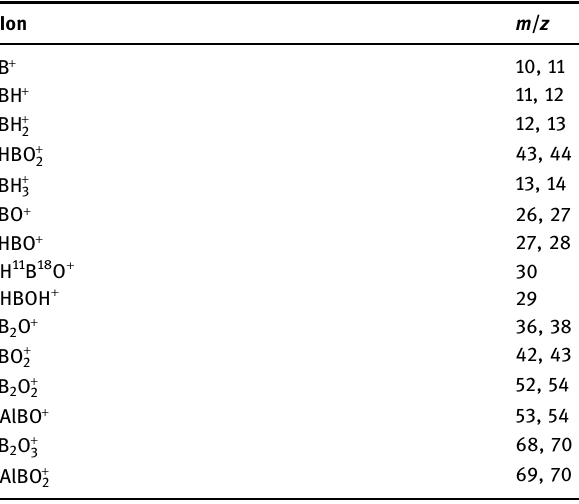
Table 3: The ions of interest studied in the MBMS and their corre - sponding m / z ratio